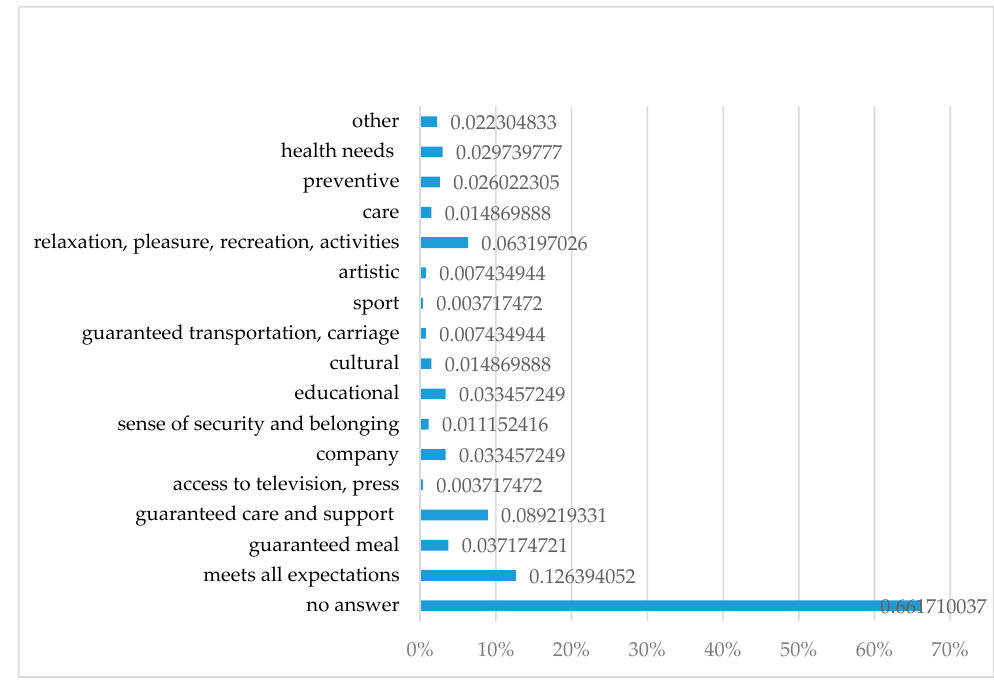
Figure 4. Potential needs met at day care centres in Poland from the perspective of the attendees. Abbreviations: % , percent.